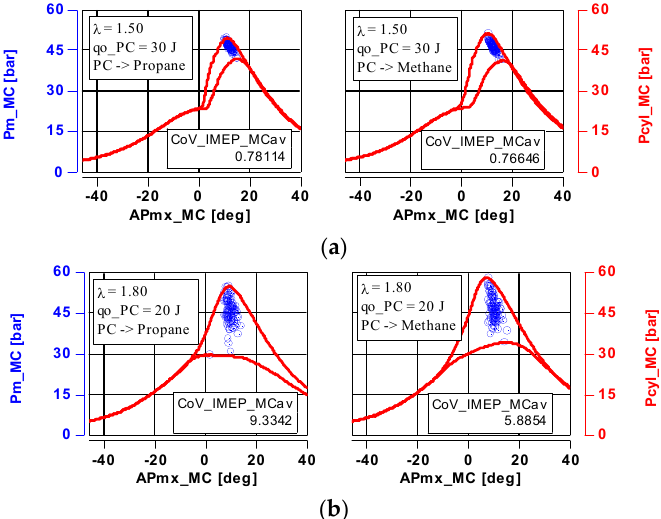
Figure 6. Stability of engine operation determined by maximum cylinder pressure Pmx (blue dots): ( a ) smallest CoV(IMEP) < 1% when burning methane and propane: λ = 1.5 Eqo_PC = 30 J; ( b ) largest CoV(IMEP) > 10% when burning methane and propane: λ = 1.8 Eqo_PC = 20 J. A comparison of IMEP values at each point of engine operation is brie fl y shown in Figure 7. All curves are drawn in the same color, but those showing signi fi cant deviations are marked in blue or black. It can be seen from the data presented that the highest in ‐ stability of operation occurs at λ = 1.8. Two curves signi fi cantly deviating from the sta ‐ bility criterion of CoV(IMEP) < 3.5% were recorded. The maximum values are 9.33% and